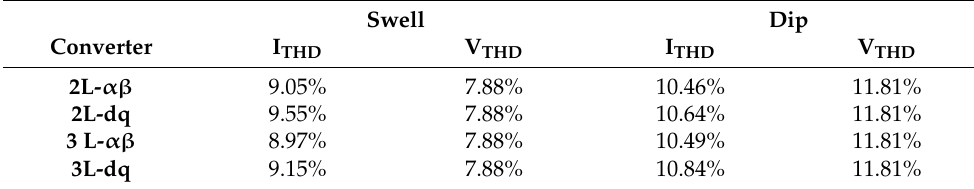
Table 4. Case 2 results.